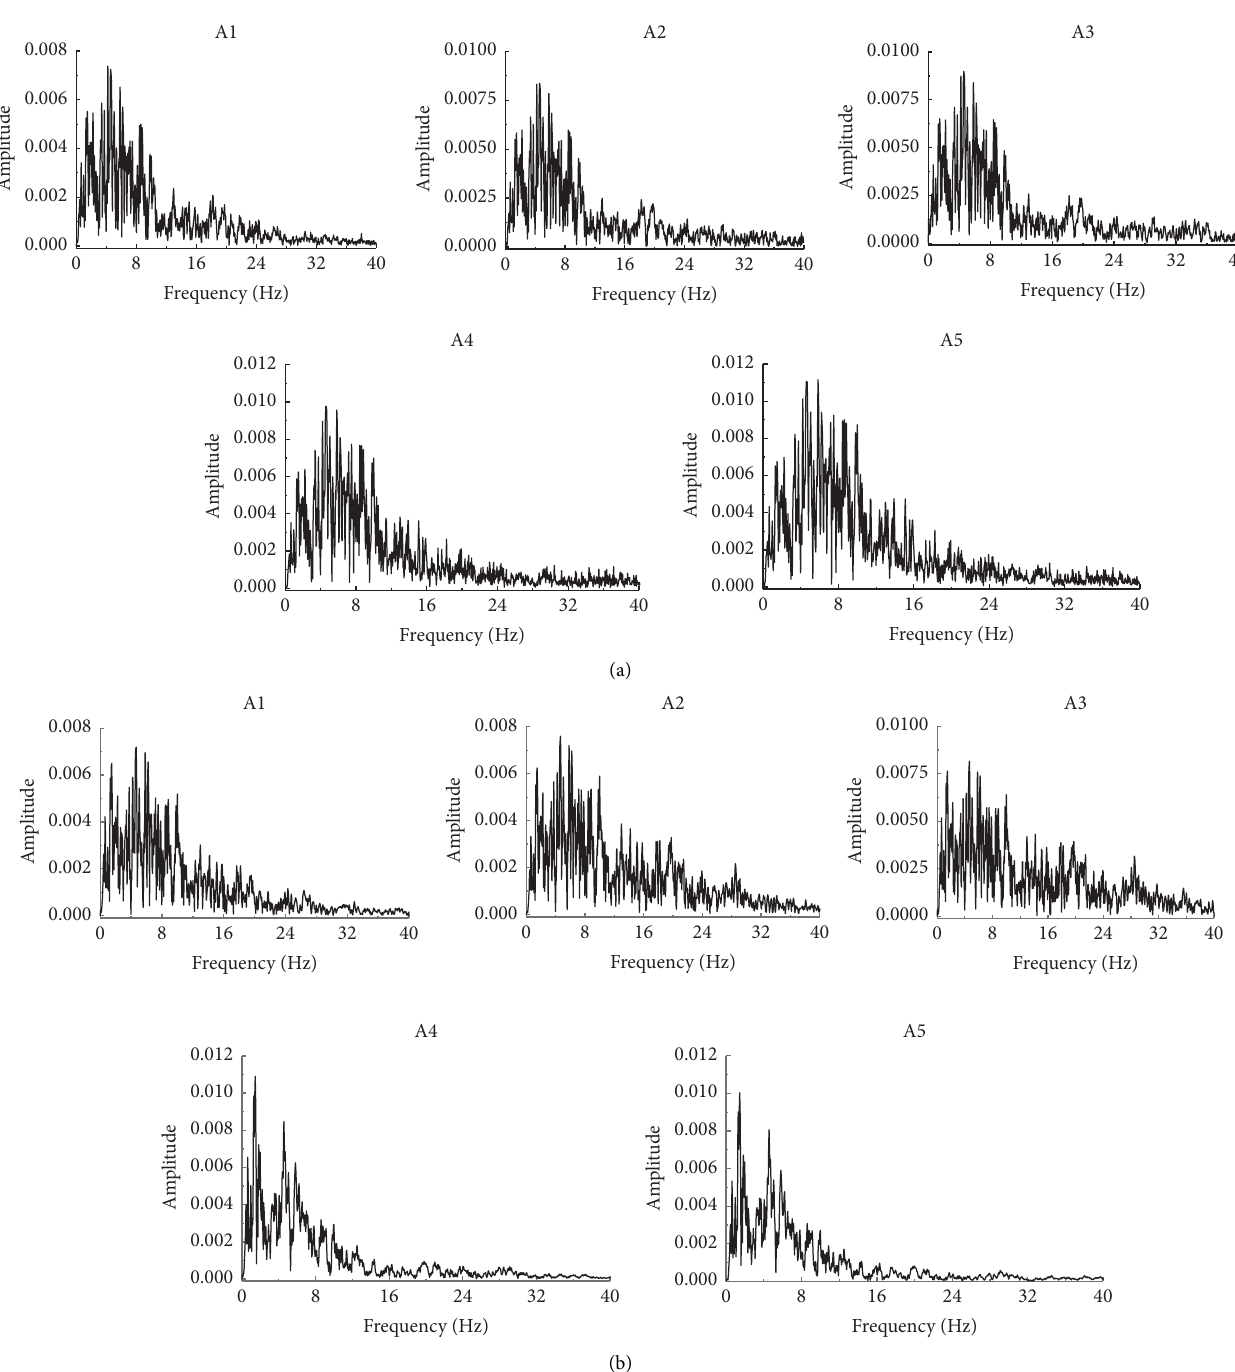
Figure 9: Case 1 Fourier spectrum of soil acceleration. (a) Test 1 accelerated Fourier spectrum of soil layer. (b) Test 2 acceleration Fourier spectrum of soil